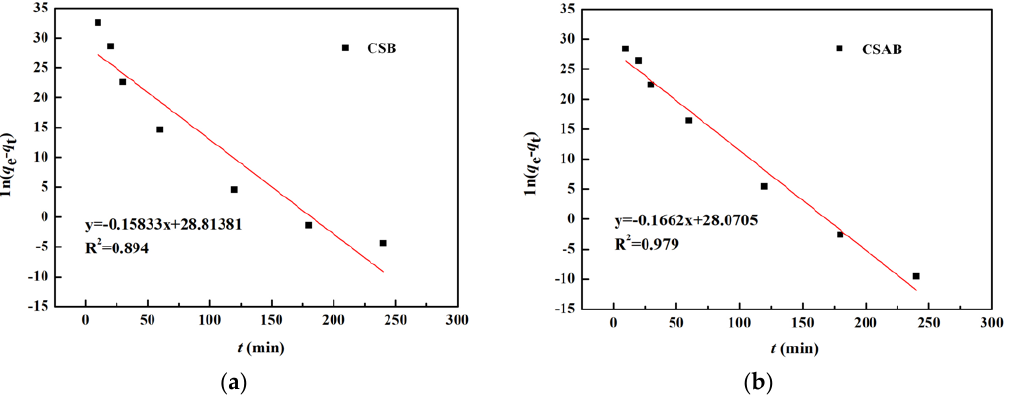
Figure 9. Pseudo first-order model for adsorption of diesel oil onto: ( a ) CSB; ( b ) CSAB.